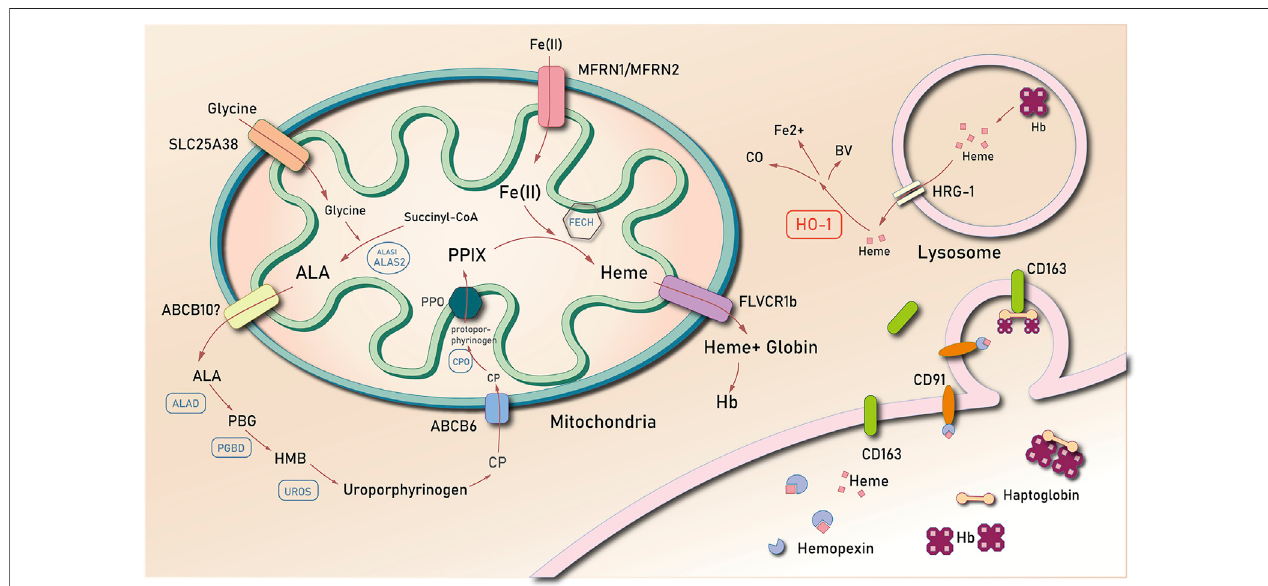
FIGURE 1 | The biosynthesis and degradation of heme. Abbreviations: δ -aminolevulinic acid (ALA); coproporphyrinogen III (CP); protoporphyrin IX (PPIX); ferrochelatase (FECH); feline leukemia virus subgroup C cellular receptor (FLVCR); heme oxygenase 1 (HO-1); hemopexin (Hx); low-density lipoprotein receptor-related protein/CD91 (LDR/CD91); heme-responsive gene 1 (HRG-1); ATP binding cassette subfamily B member 6 (ABCB6); ATP binding cassette subfamily B member 10 (ABCB10); Mitoferrin-1 (Mfrn1); ALA dehydrase (ALAD); uroporphyrinogen III synthase (UROS); hydroxy-methyl bilane (HMB); porphobilinogen (PBG); PBG deaminase (PGBD); hemoglobin (Hb).